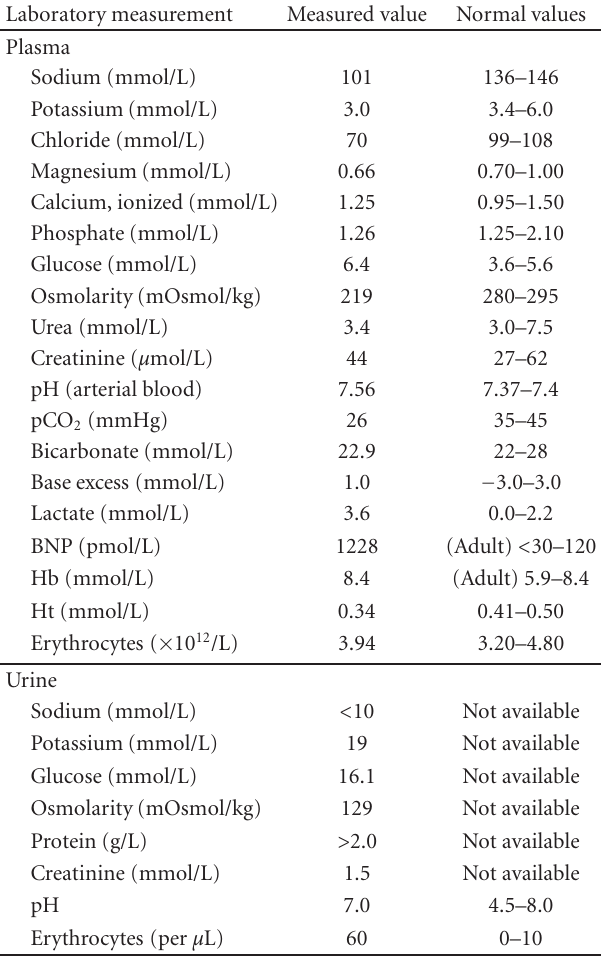
Table 1: Laboratory values in plasma and urine, measured in the patient at readmission to the